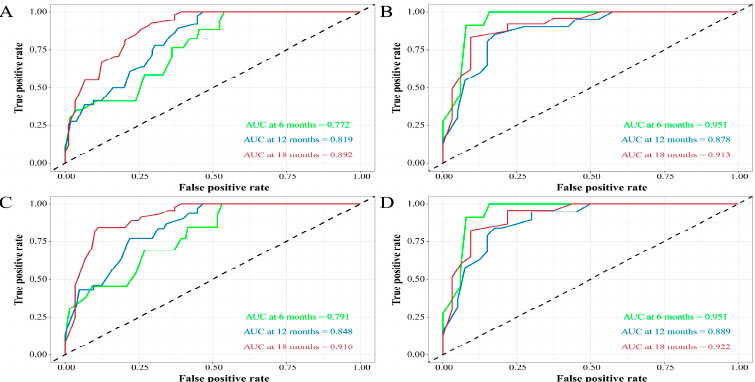
Figure 3. ROC curves for predicting 6-, 12-, and 18-month overall survival (OS) and cancer-specific survival (CSS) rates of the nomograms. ( A , B ) ROC curves for OS in training and internal validation sets. ( C , D ) ROC curves for CSS in training and internal validation sets.